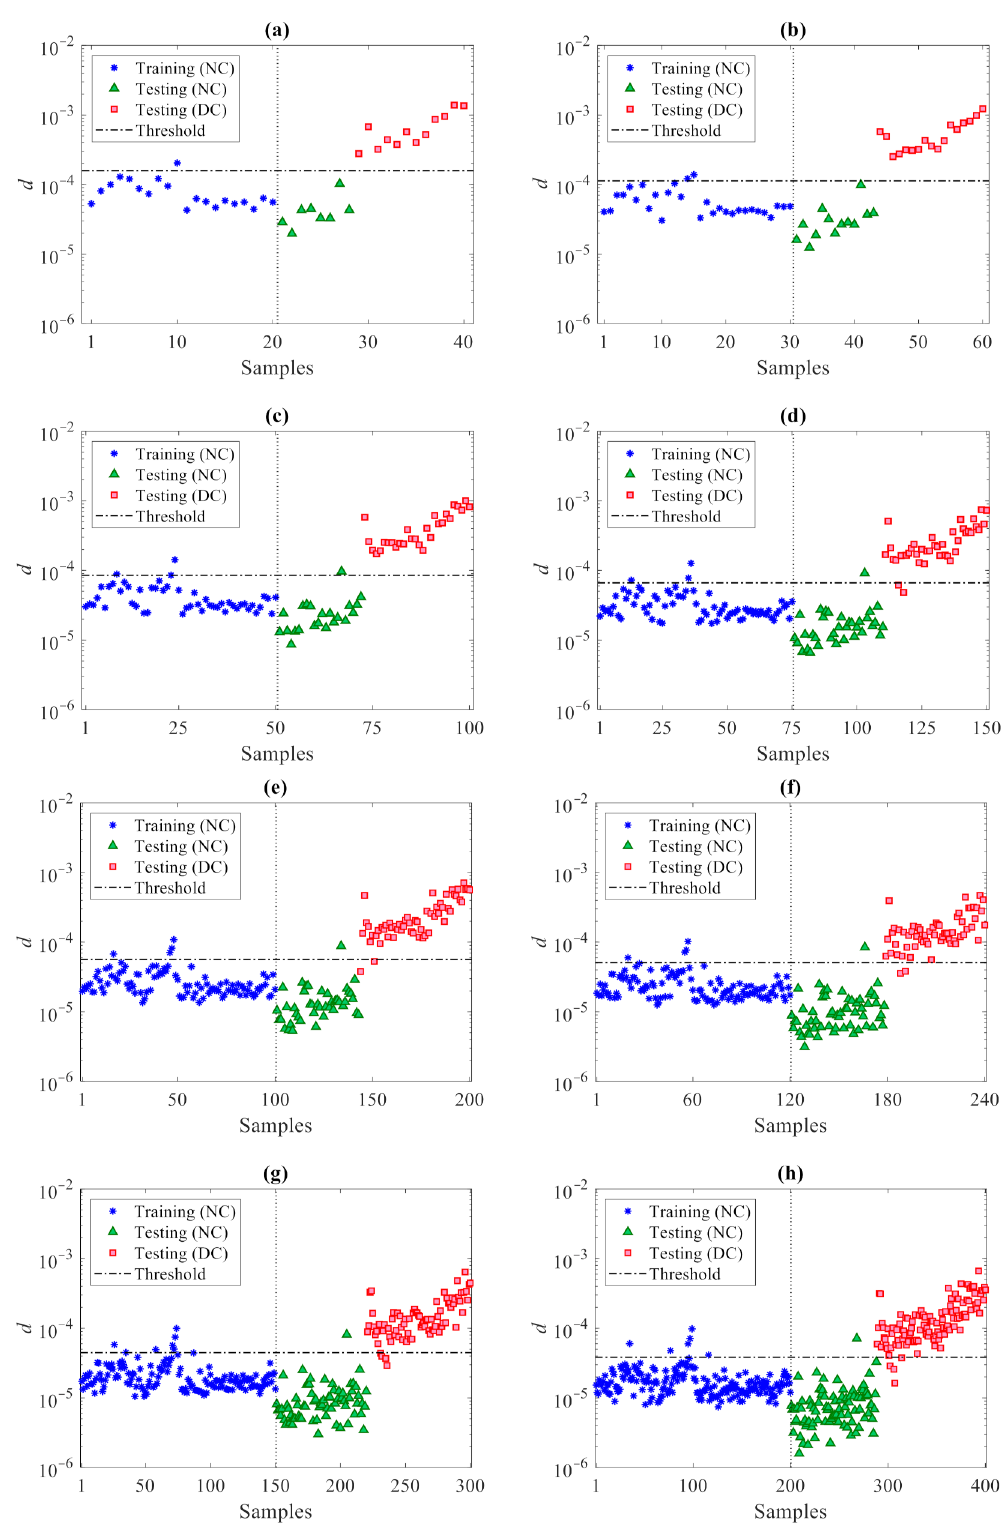
Figure 12. Z24 Bridge: damage detection via the proposed CMDS method at varying number of partitions ( a ) p = 20, ( b ) p = 30, ( c ) p = 50, ( d ) p = 75, ( e ) p = 100, ( f ) p = 120, ( g ) p = 150, ( h ) p =